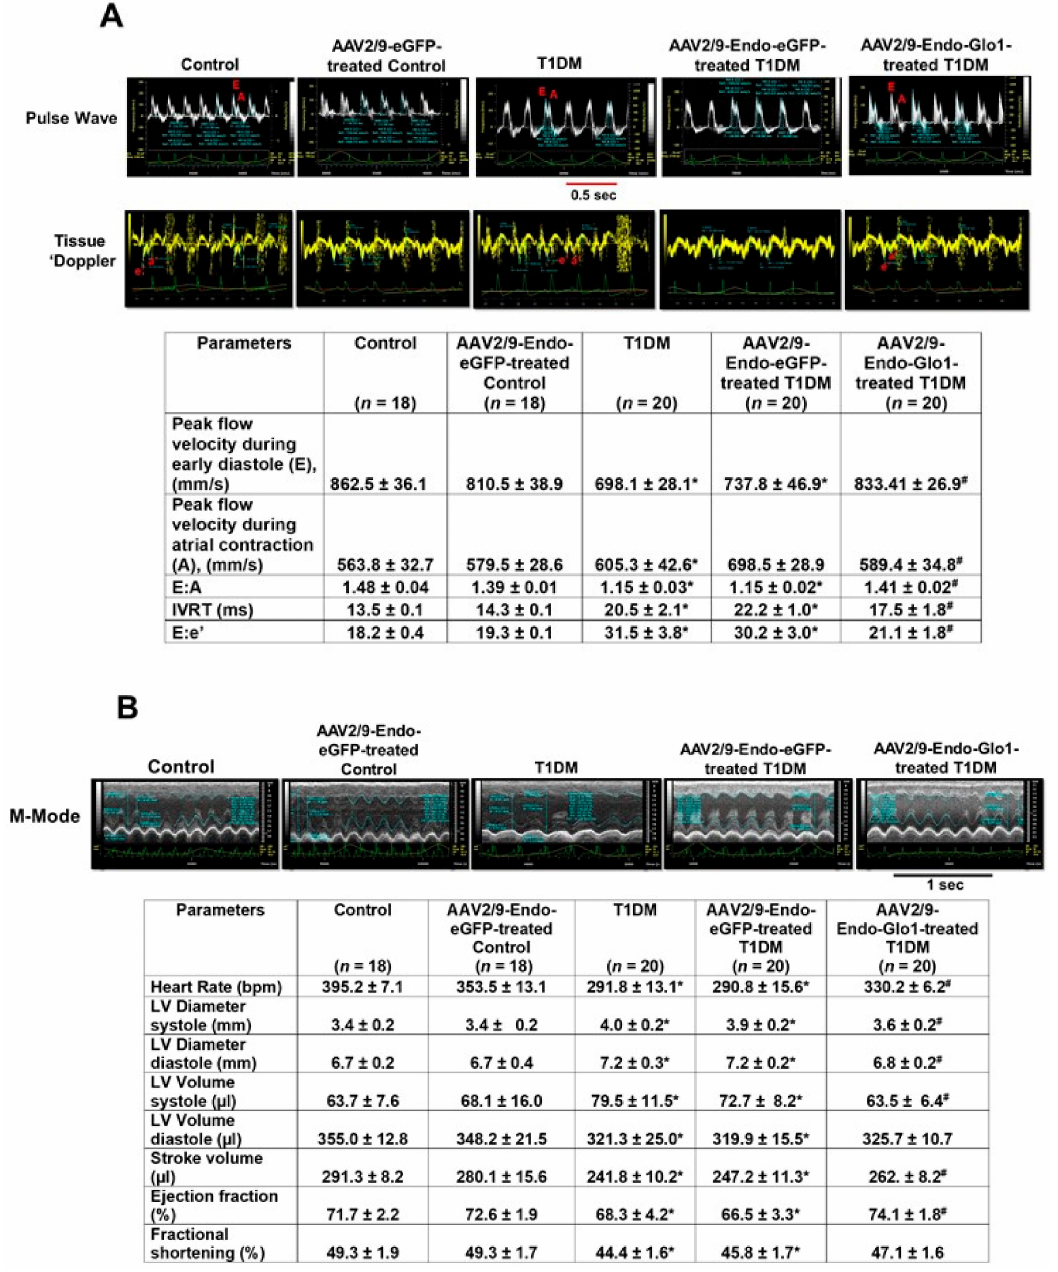
Figure 1. Original traces showing in vivo cardiac function of hearts from control, T1DM and Table 1. rats. ( A ) shows representative pulse-wave and tissue Doppler echocardiograms of hearts from control, AAV2 / 9-Endo-eGFP-treated Con, T1DM, AAV2 / 9-Endo-eGFP-treated T1DM, and AAV2 / 9-Endo-Glo1-treated DM rats. The table below shows mean ± S.E.M for peak flow velocity during early diastole (E), peak flow velocity during atrial contraction (A), E: A ratio, IVRT, and